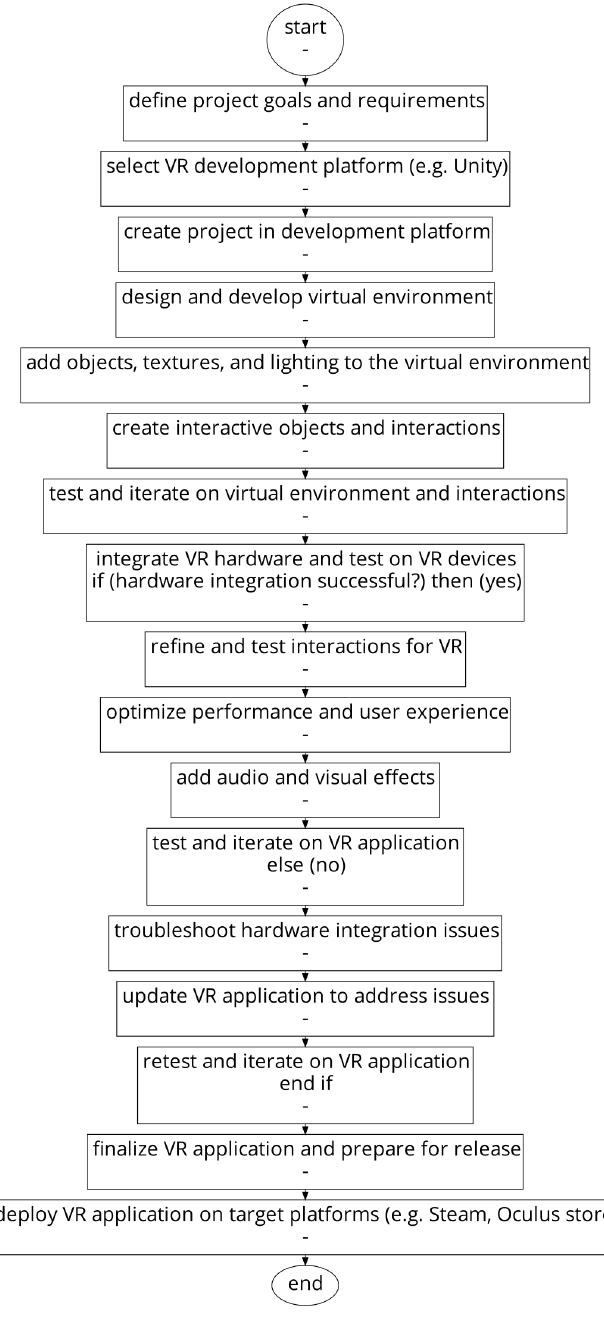
Figure 2. Flowchart of VR application